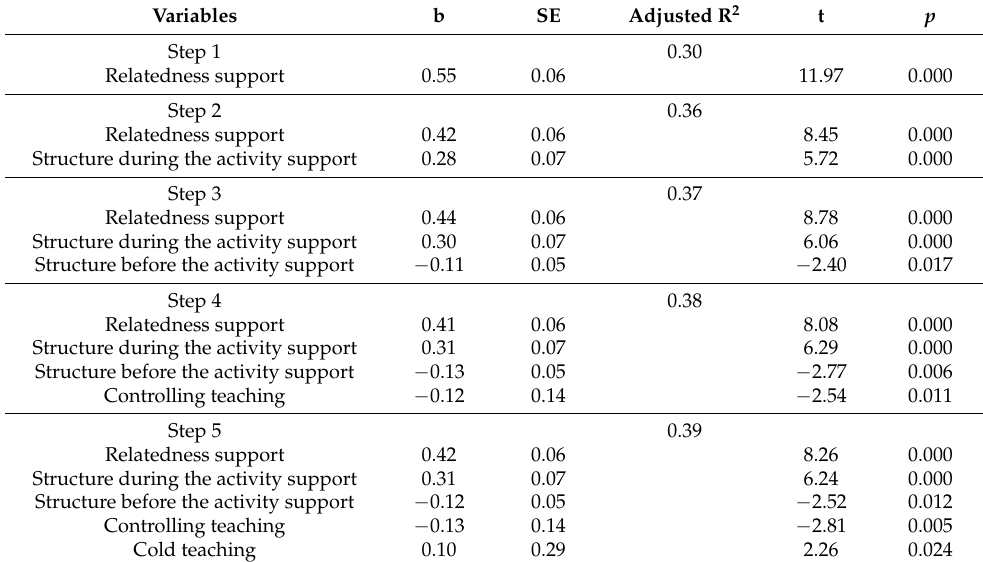
Table 3. Stepwise regression analysis for students’ behavioral